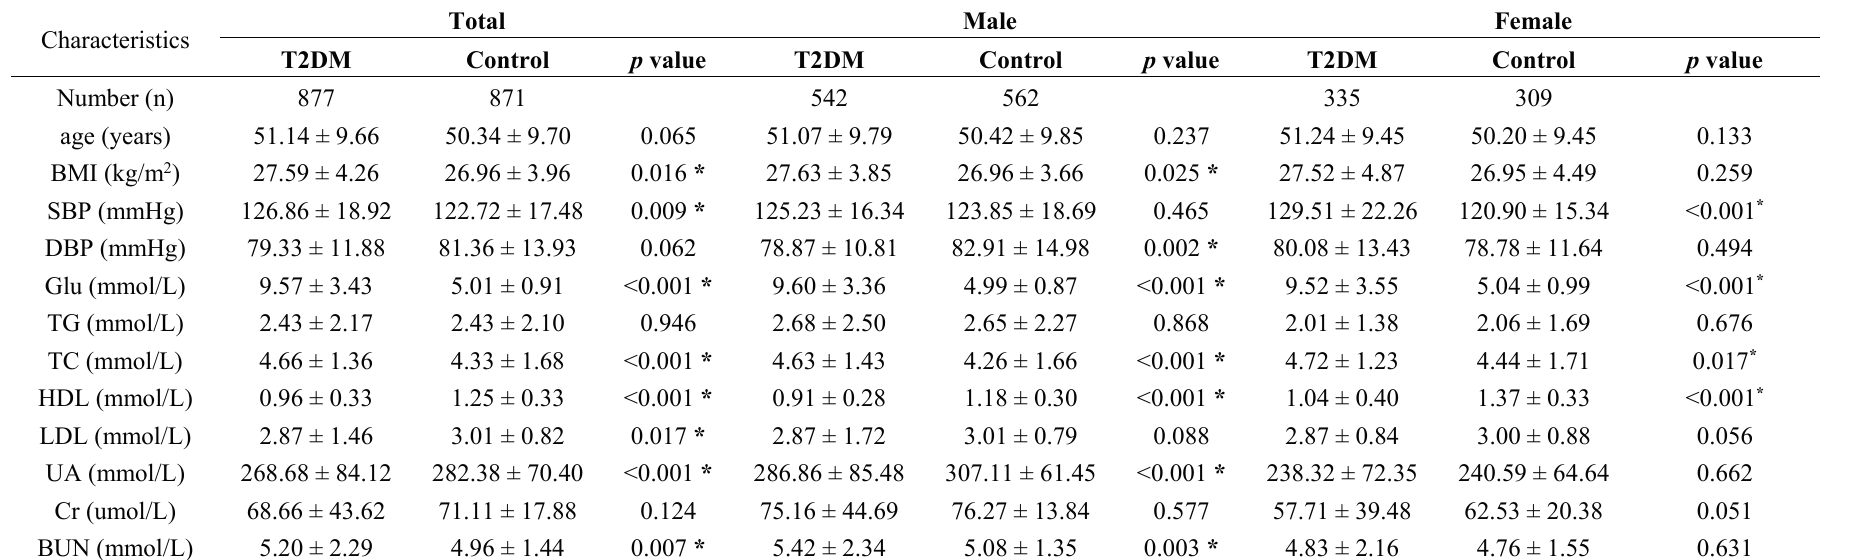
Table 2. Demographic and clinical characteristics of study